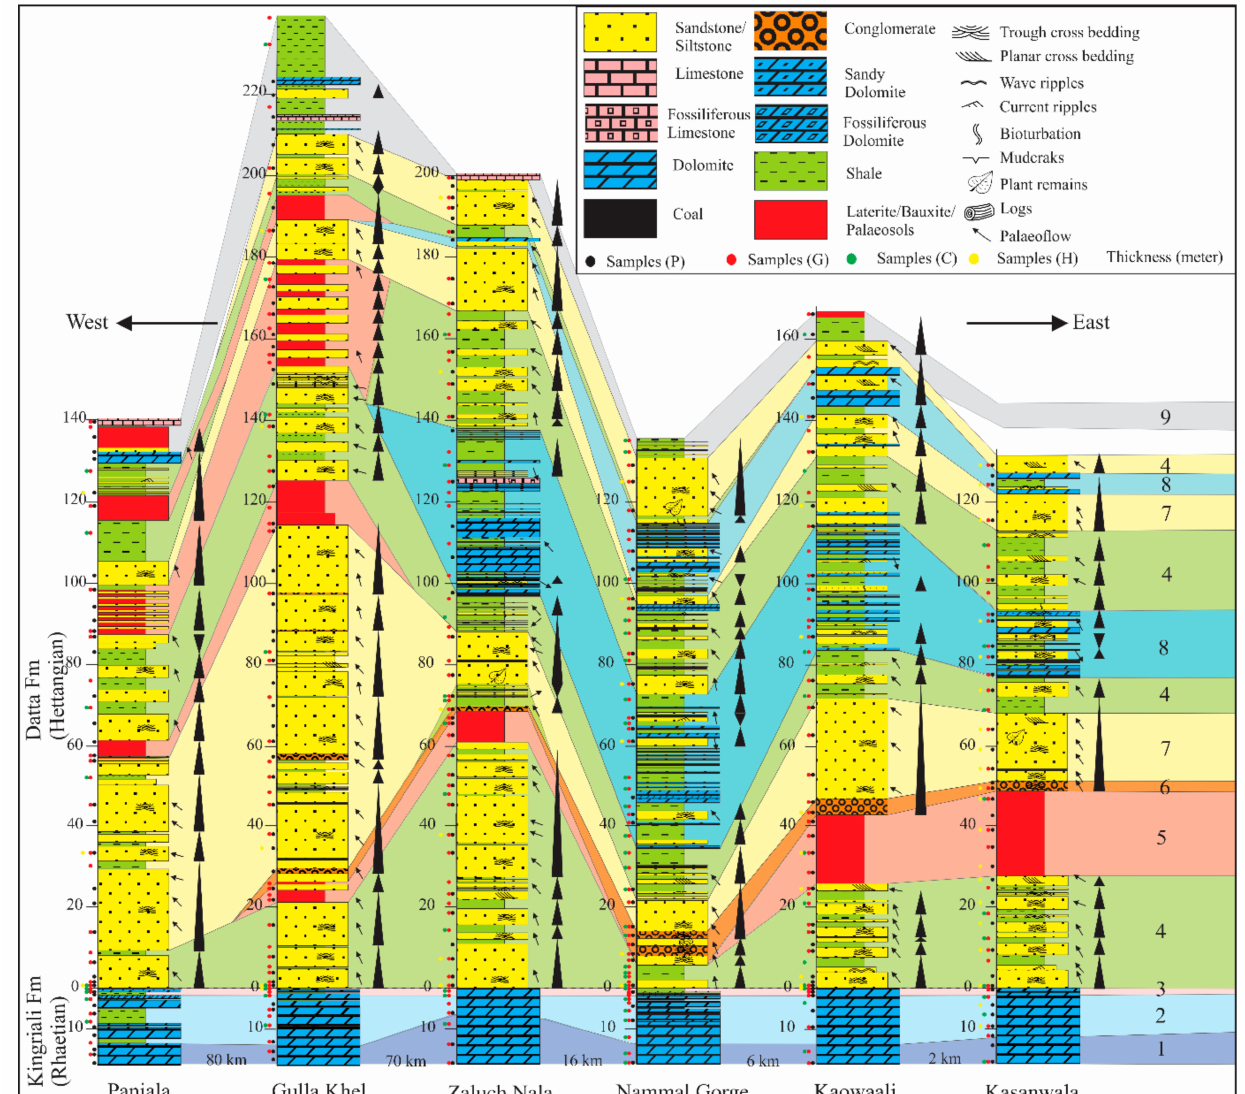
Figure 3. Measured stratigraphic sections in the Salt and Trans–Indus ranges. Sedimentary structures, sample locations, and grain size trend are displayed on each log. Vertical facies variation is displayed and a general lithofacies correlation is also marked on the lithological logs. 1 = dolostone lithofacies; 2 = shallow marine dolostone and shale lithofacies; 3 = lagoonal shale and evaporites lithofacies; 4 = channel margin sandstone lithofacies and overbank-floodplain shale lithofacies; 5 = laterite-bauxite lithofacies; 6 = channel belt conglomerate lithofacies; 7 = channel belt sandstone lithofacies; 8 = lagoonal shale lithofacies and lagoonal carbonates lithofacies; and 9 = contact zone with the overlying strata. The distance between each section is displayed in kilometers. (P) = petrography; (G) = geochemistry; (C) = clay mineralogy; (H) = heavy